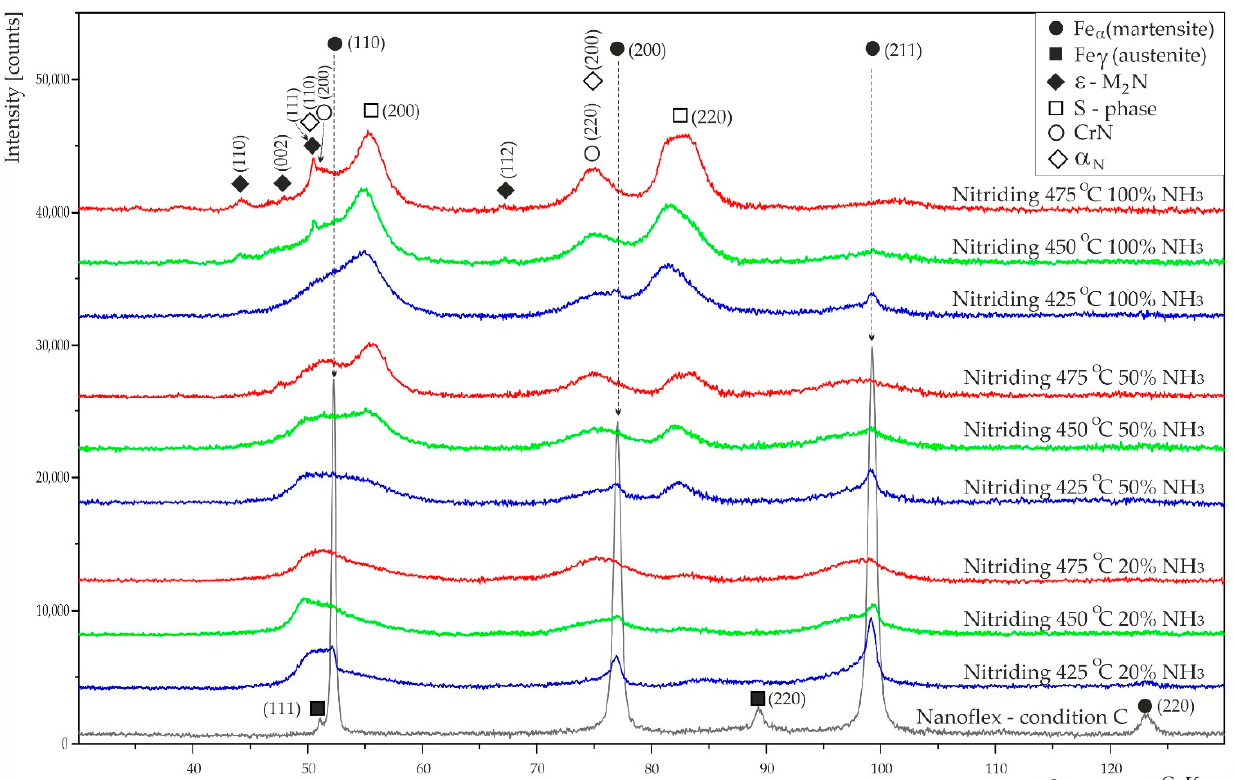
Figure 6. Secondary electron images of the surface of the nitrided layer at a temperature of 425 °C for 4 h in an atmosphere containing 20% NH 3 ; ( a ) surface relief, ( b ) surface nitrides